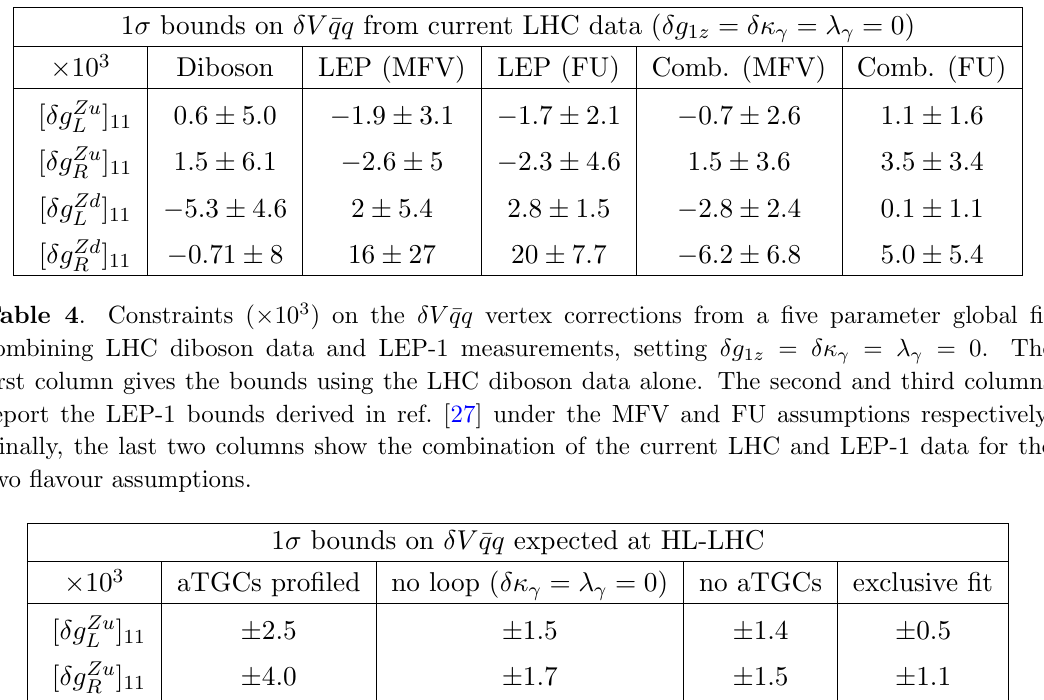
Diboson LEP (MFV) LEP (FU)